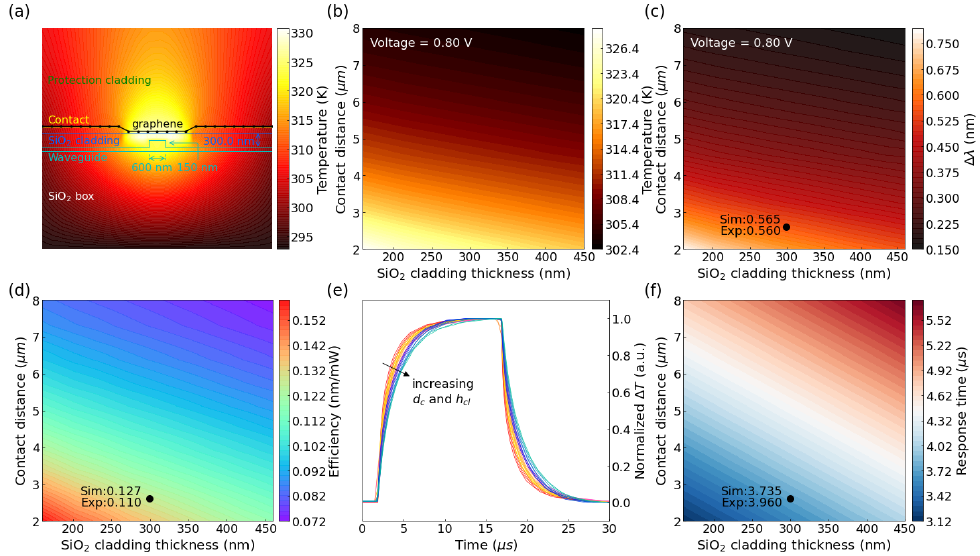
Figure 5. Simulation of the graphene-on-SOI structure. ( a ) Schematic cross-section and simulated temperature distribution of the graphene-on-SOI phase shifter with a contact distance of 2.6 μ m under a driving voltage of 0.8 V. ( b ) Temperature mapping and ( c ) wavelength shift with different contact distances ( h cl ) and cladding thicknesses ( d c ) at 0.8 V. ( d ) Heating efficiency η of the device with different h cl and d c . ( e ) Dynamic heating progress of the waveguide with different h cl and d c . ( f ) Response time mapping with h cl and d c . Simulated (Sim) and experimental (Exp) values of our devices are labelled in ( c , d ), and ( f ) with structural points marked by circles.